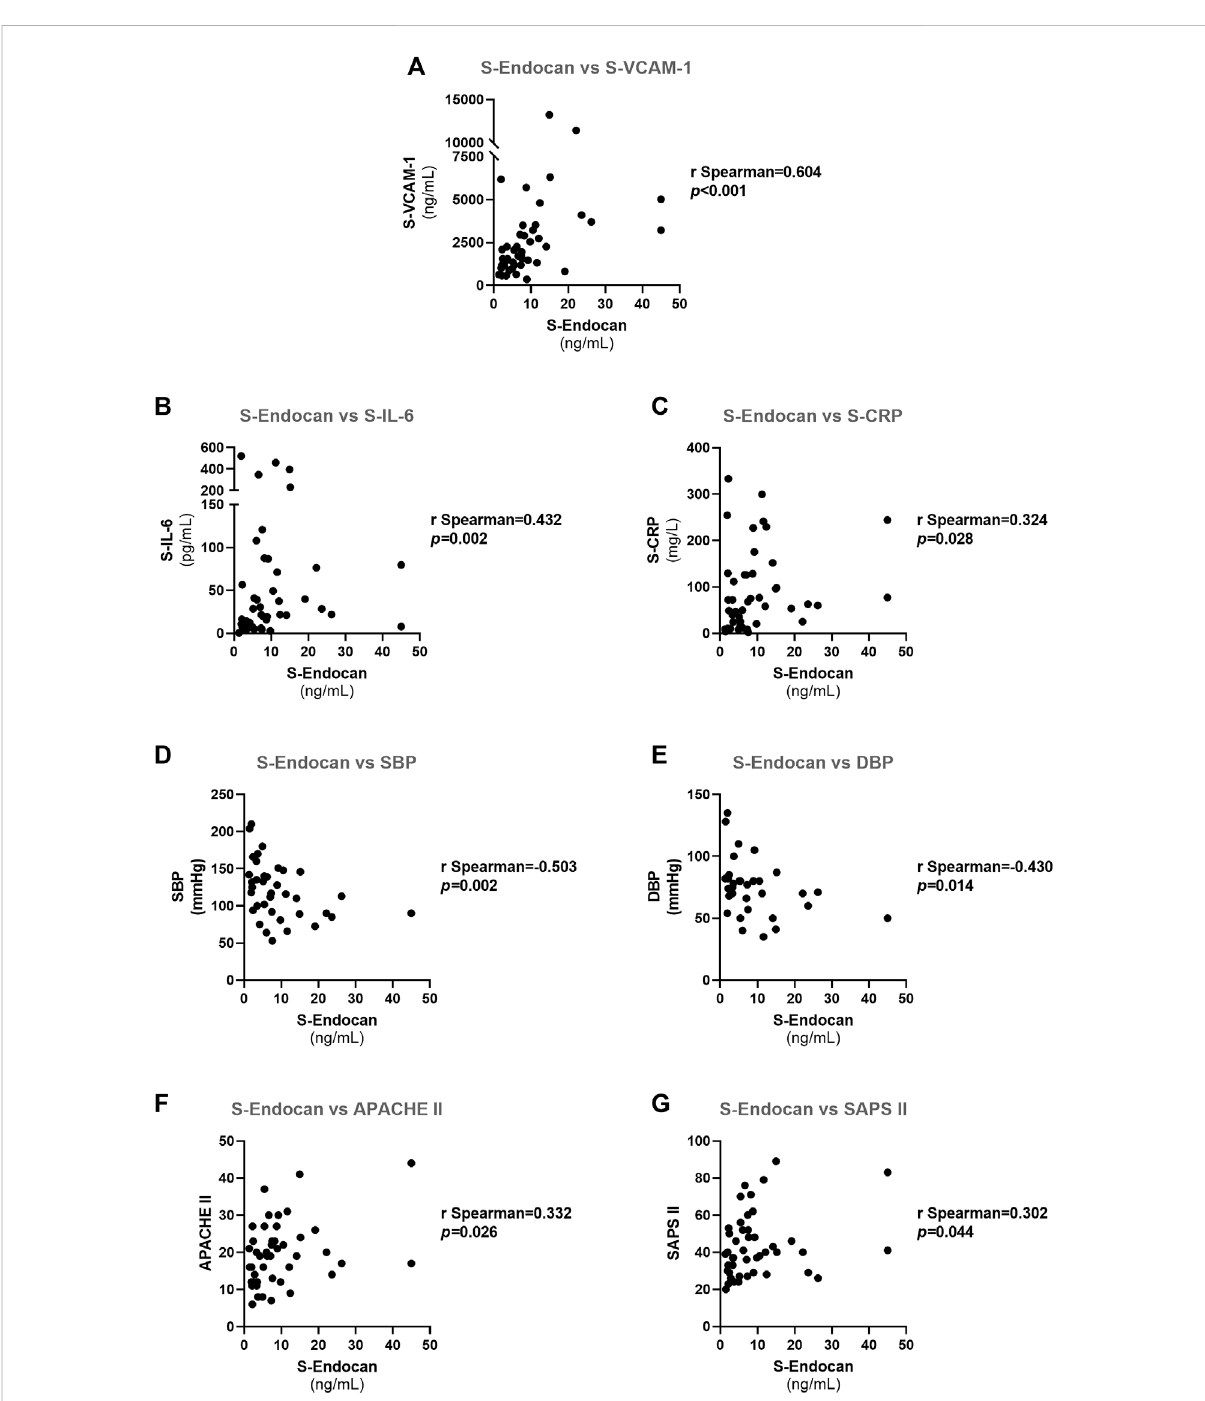
FIGURE 6 Spearmancorrelationsforserumendocaninallpatientsatadmission: (A) S-Endocan vs .S-VCAM-1; (B) S-Endocan vs .S-IL-6; (C) S-Endocan vs . S-CRP; (D) S-Endocan vs . S-SBP; (E) S-Endocan vs . DBP; (F) S-Endocan vs . APACHE II; (G) S-Endocan vs . SAPS II. APACHE II, acute physiology and chronic health evaluation II; DBP, diastolic blood pressure; SAPS II, simpli fi ed acute physiology score (SAPS) II; SBP, systolic blood pressure; S-Endocan, serum endocan; S-CRP, serum C-reactive protein; S-IL-6, serum interleukin 6; S-VCAM-1, serum vascular cell adhesion molecule